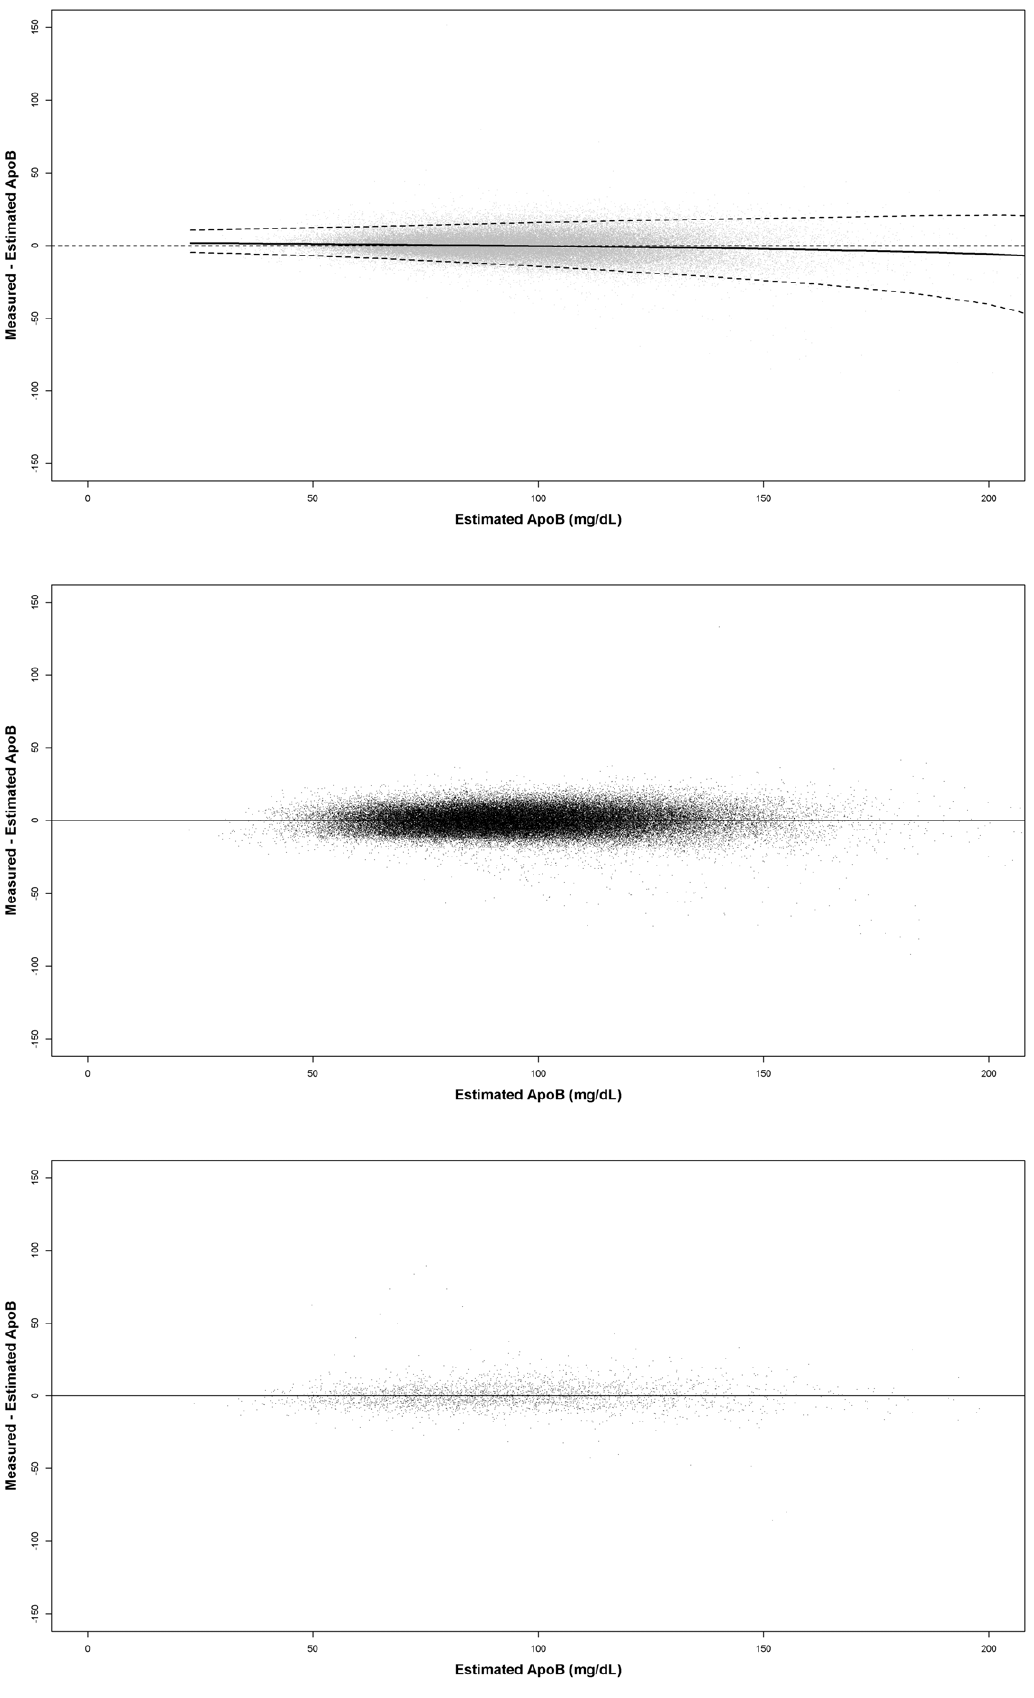
Figure 2. Residual plots for the datasets. Development dataset ( A ), internal validation dataset ( B ), and external validation dataset ( C ). Solid line is the 50 th quantile regression line, and the dotted lines are the 2.5 th and 97.5 th quantile regression lines, respectively. doi:10.1371/journal.pone.0051607.g002 PLOS ONE |